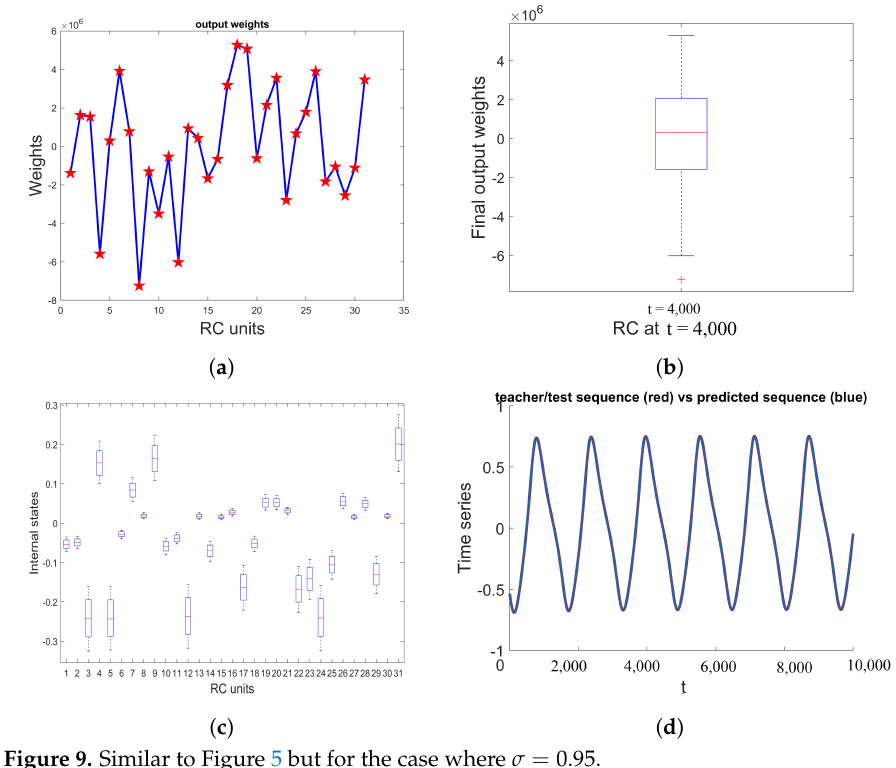
Figure 9. Similar to Figure 5 but for the case where σ = 0.95.